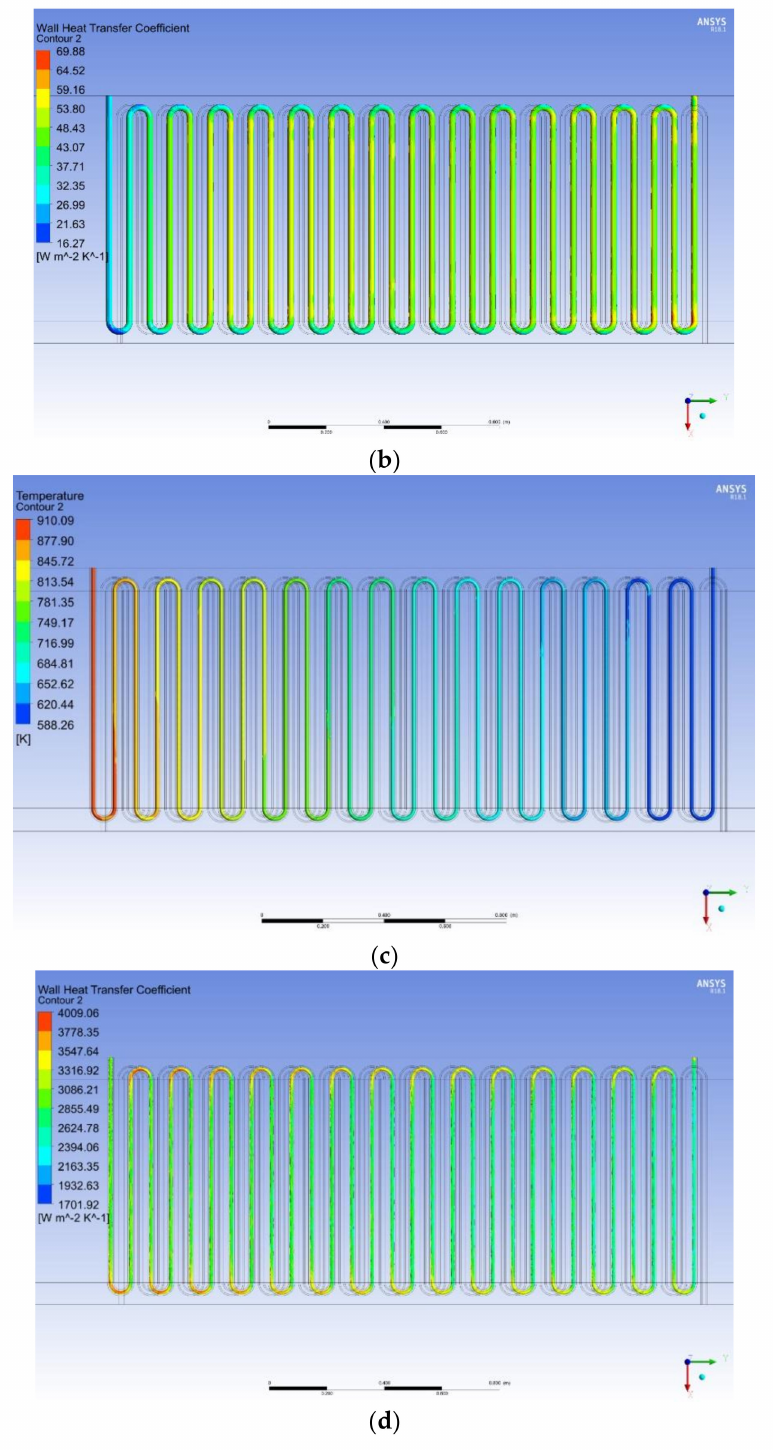
Figure 7. CFD results around the heat exchanger tube: ( a ) temperature distributions on the outer tube surface, ( b ) heat transfer coe ffi cient distributions on the outer tube surface, ( c ) temperature distributions on the inner tube surface, ( d ) heat transfer coe ffi cient distributions on the inner tube